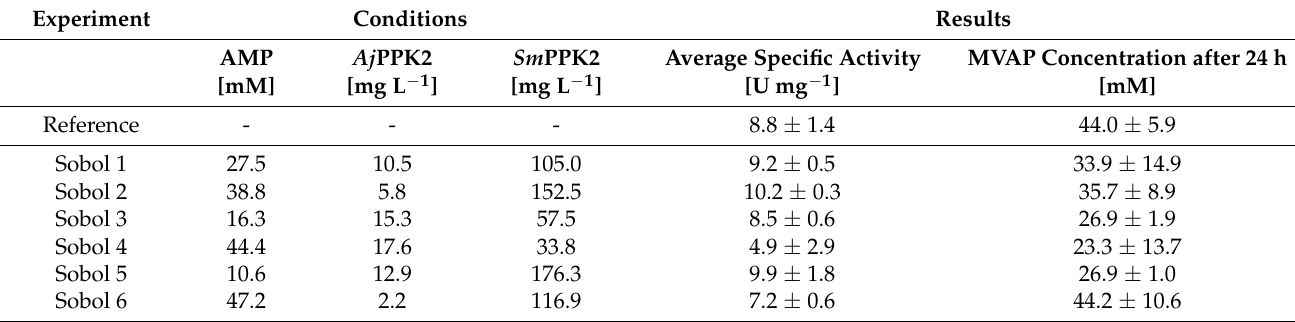
Table 2. Conditions of the Sobol experiments as parameter concentrations and the respective results of specific activity and product concentration. Enzyme assays were performed in triplicates with purified enzymes in 1.5 mL Eppendorf tubes. Enzyme assays contained 0.2 mg mL − 1 of MVK, 50 mM of MVA, 55 mM of polyP, 3 mM of Na 3 VO 4 , 0.043 mM of NADP + , 0.43 mM of CoA, 170 mM of glucose, 200 mM of NaOAc, and 20 mM of MgCl 2 in 0.35 mL of the reaction volume, filled up with activity buffer (100 mM Tris-HCl, 150 mM NaCl, 10% glycerol, 20 mM MgCl 2 , pH 7.5). AMP, Aj PPK2, and Sm PPK2 were added in various concentrations, except in the reference assay where 55 mM ATP was added. The reaction was incubated at 30 ◦ C in a multirotator with 30 rpm. Samples were taken regularly, and enzymes were inactivated at 95 ◦ C for 5